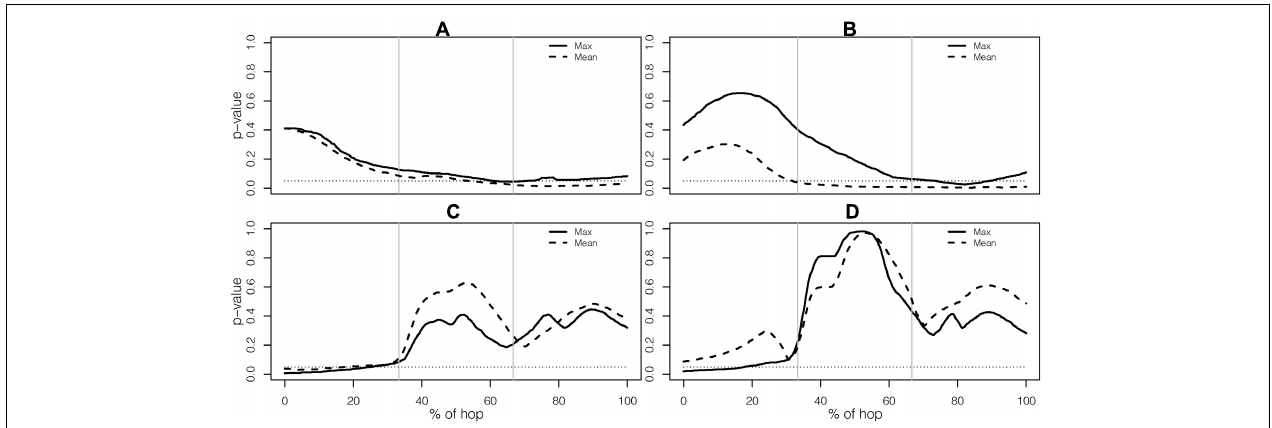
FIGURE 3 | Multivariate p -value functions for outcome measure Mean and Max for (A) the trunk when comparing the injured leg to the non-dominant leg, (B) the trunk when comparing the injured leg to the dominant leg, (C) the knee when comparing the injured leg to the non-dominant leg, and (D) the knee when comparing the injured leg to the dominant leg. The dotted line indicates the level of